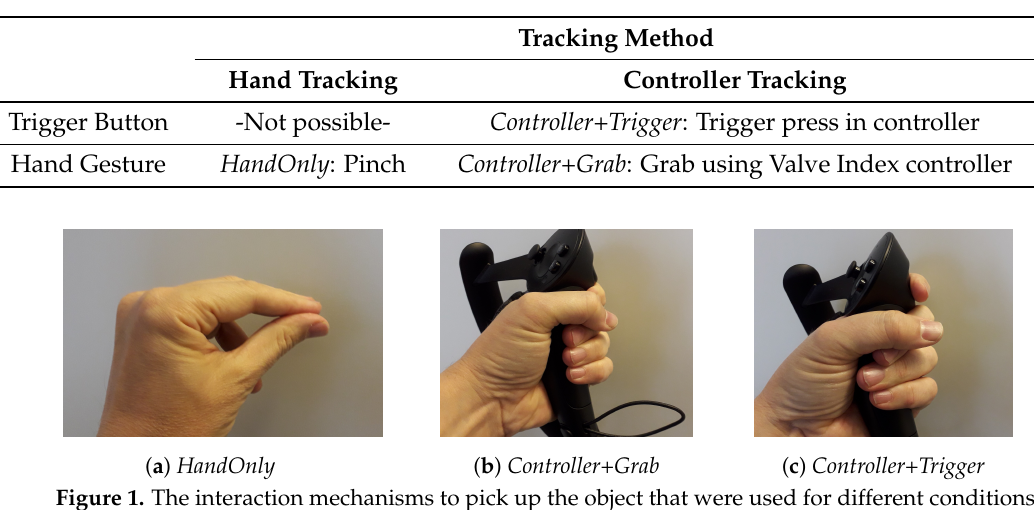
Table 1. The three interaction techniques ( HandOnly , Controller+Trigger and Controller+Grab ) based on two position tracking methods (hand and controller tracking), and two object pick up action types (trigger press and hand gesture).